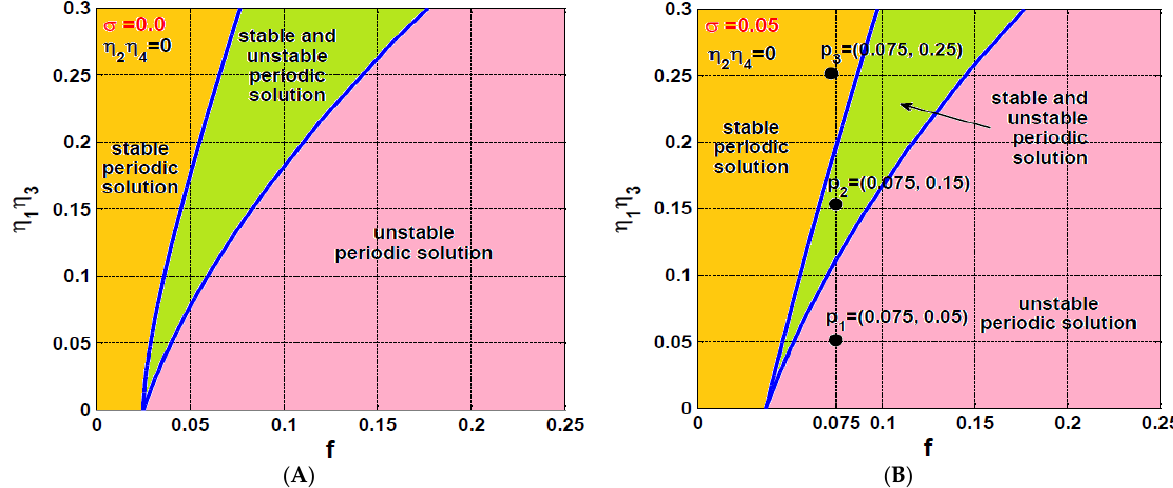
Figure 10. Stability chart of the rotor system in f − η 1 η 3 plane at two different values of σ when η 2 η 4 = 0.0: ( A ) σ = 0.0, and ( B ) σ = 0.05.